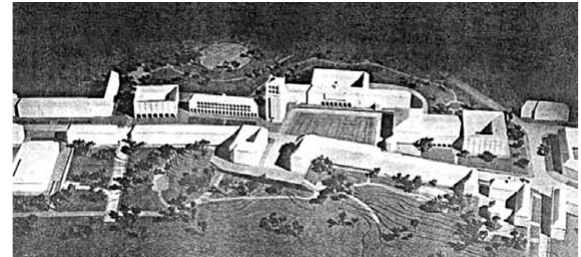
fig. 4. The model of an other city center planned for Kazincbarcika